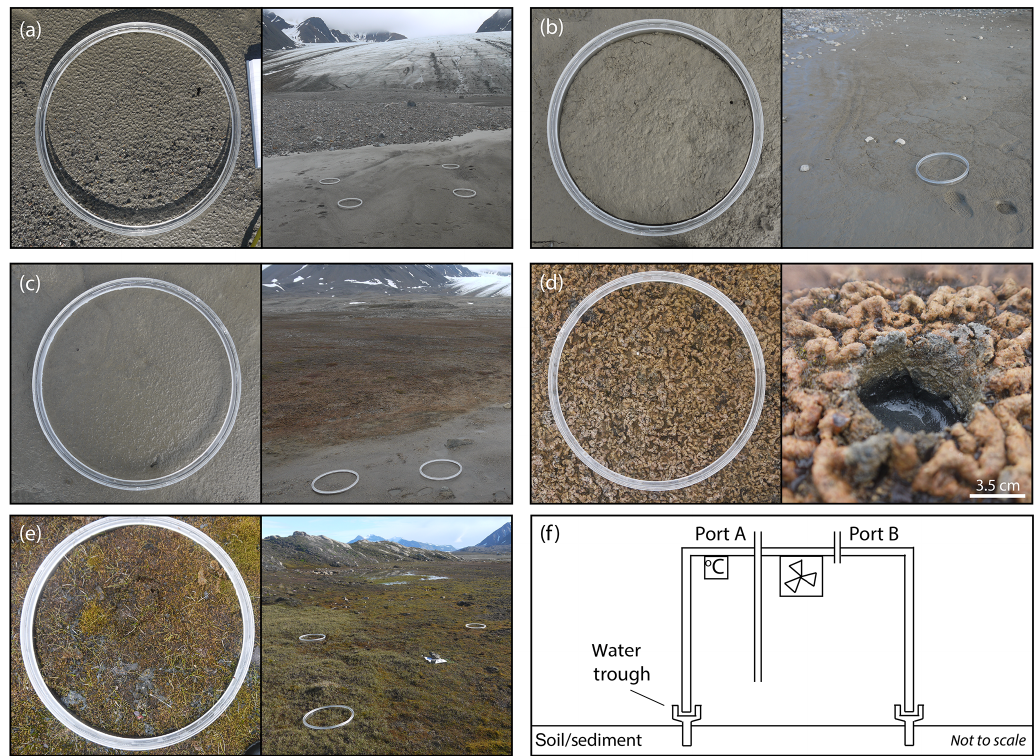
Figure 2. The visible differences in land surface type and colonising species at the snout (a) , pond mat (b) , disturbed mat (c) , established mat (d) , and tundra (e) sites and a schematic diagram of the flux chamber’s design showing sampling ports, fan, and temperature logger (f) . The width of the chamber collar in (a) – (e) is 0.39m.